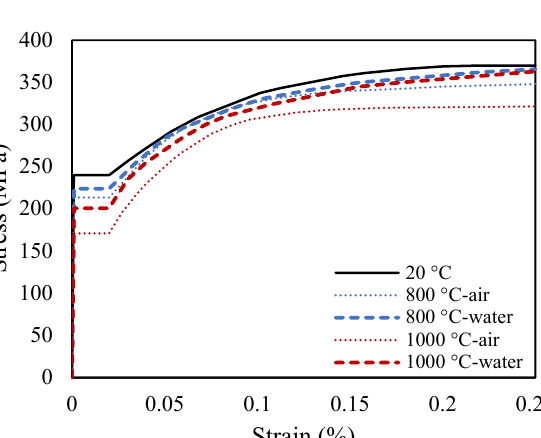
Table 2. Description of fire scenarios. S t r u c t u r e